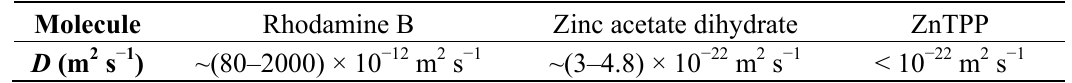
Table 1. Summary of effective diffusion coefficients for the three molecules used in this